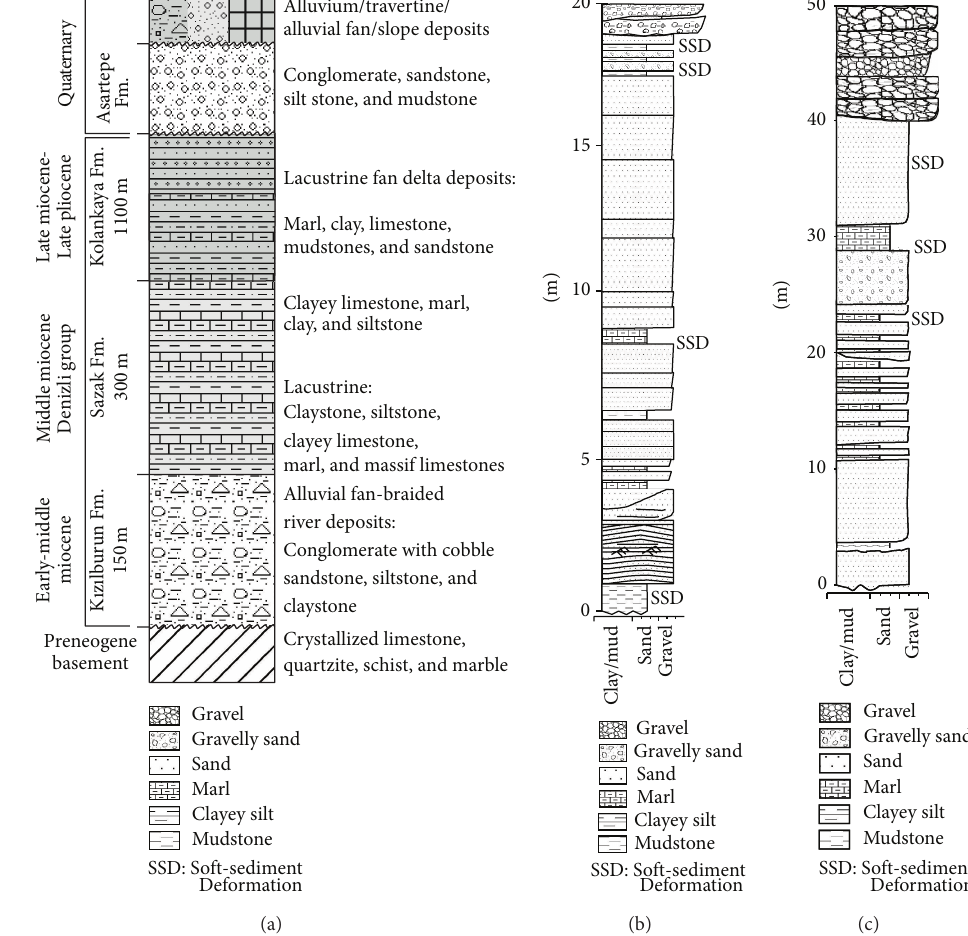
Figure 2: (a) Composite stratigraphy of the Denizli basin-fill succession (not to scale; after Alc¸ic¸ek et al. [27]). (b) and (c) Representative columnar sections including soft-sediment deformation structures, measured from Kolankaya Formation exposed at the western part of the study